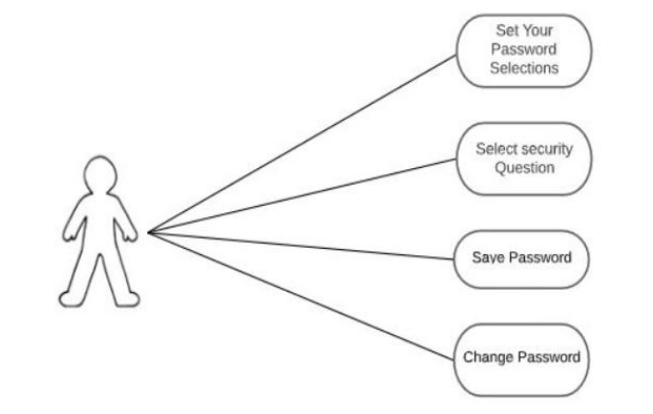
Figure 6. Use case diagram for a new user.